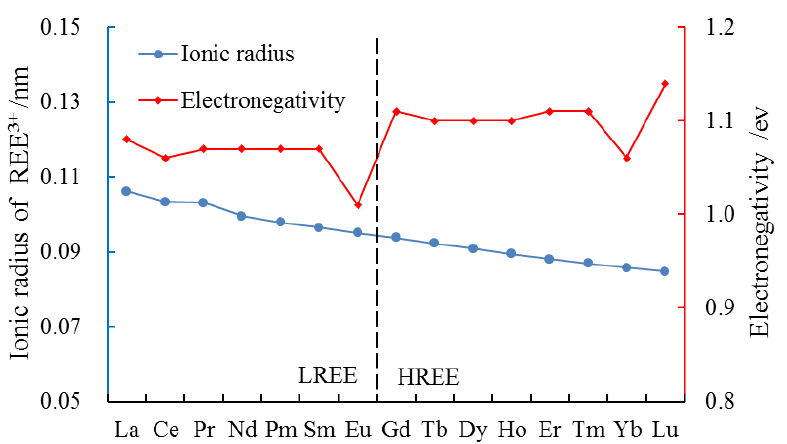
Figure 8. Electronegativity and the trivalent ionic radius distributions of REEs.